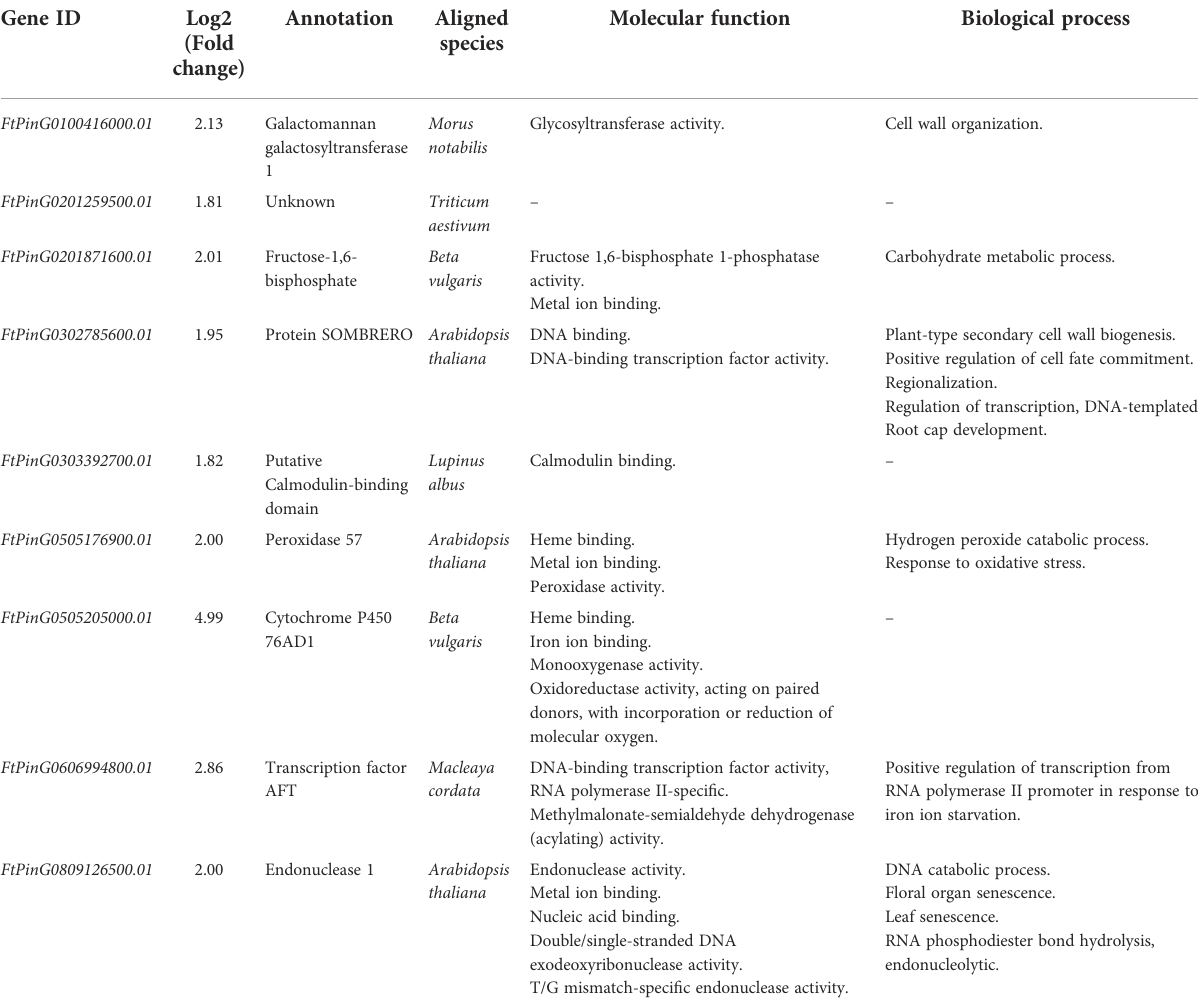
TABLE 2 The 9 core genes speci fi cally induced by Cd concentration of 50 mg/L. Gene